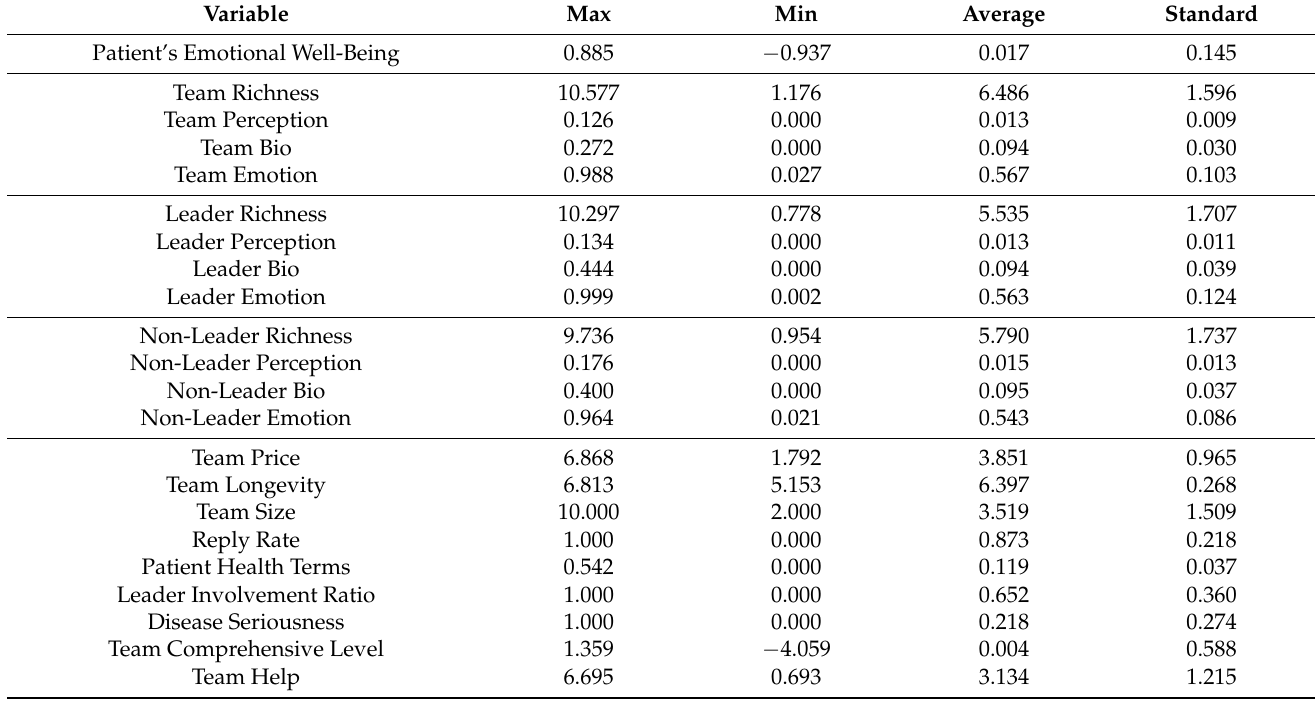
Table 5. Variable descriptive statistics (n =